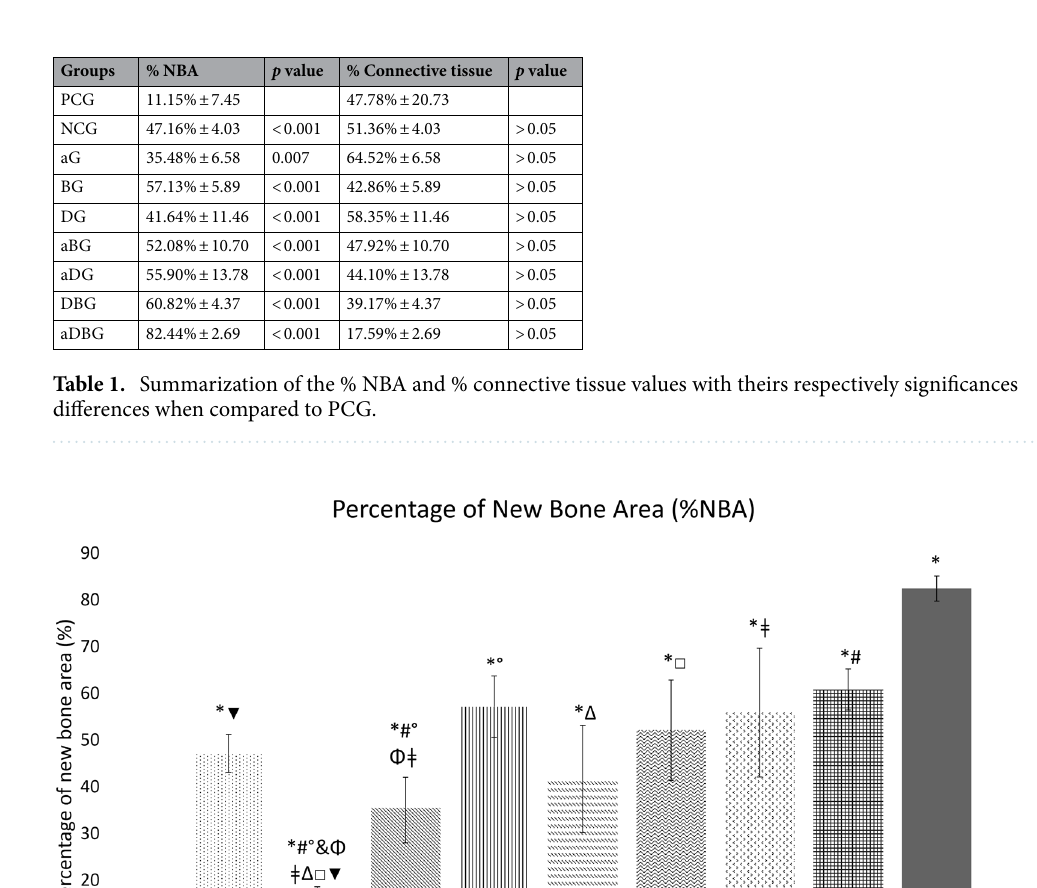
Figure 8. Graph representing the dynamics/composition of the sections, according to each group (in percentage). The components evaluated were neoformed bone area (pink), connective tissue (blue), and necrotic tissue or non-vital bone (gray).